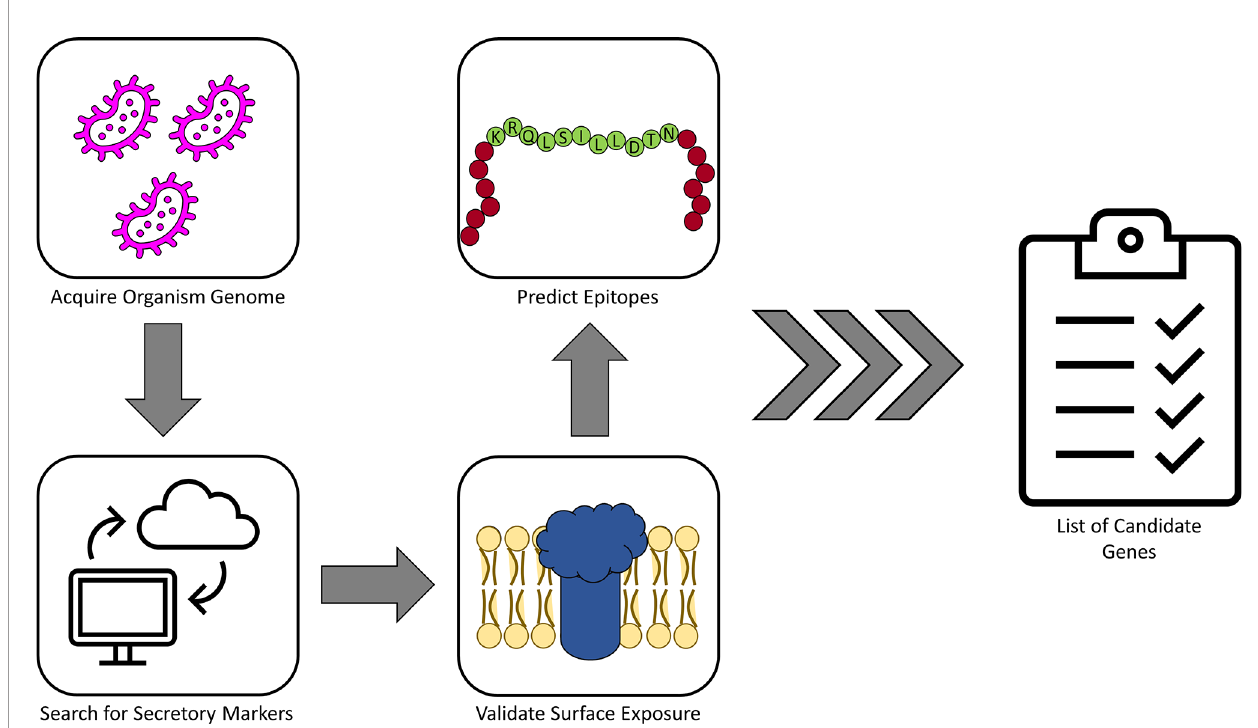
FIGURE 1 | A simpli fi ed pipeline for identifying candidate antigens. The cartoon above demonstrates a simpli fi ed version of the antigen identi fi cation pipeline described in the text. In short, once a genome has been chosen for the organism in question, this genome can be screened for genes likely to produce surface-exposed products, which represent a logical fi rst choice in identifying targets. Once a list of potential surface targets has been identi fi ed, these can be further validated by running through topology prediction tools or similar methods to verify the initial screen. From here, the list can be further narrowed down to include only gene products with suf fi cient epitope characteristics, such as those for B cells and/or T cells, leaving the researcher with a fi nalized list of candidate targets for